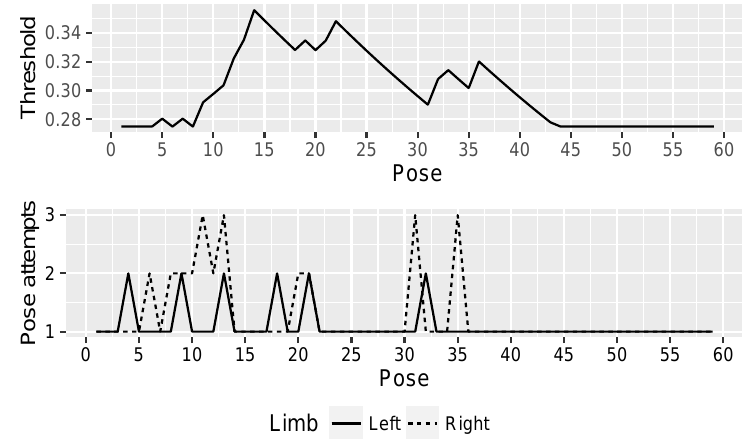
Figure 7. Patient P1: dynamic adaptation of NAOTherapist to the patient based on pose attempts. The top plot shows the evolution of the threshold parameter, in charge of adapting the tolerance of the system for determining a pose as correct. The bottom plot reveals the number of attempts needed to perform each pose of a therapy session. https://www.youtube.com/watch?v=9n9nll28rME.